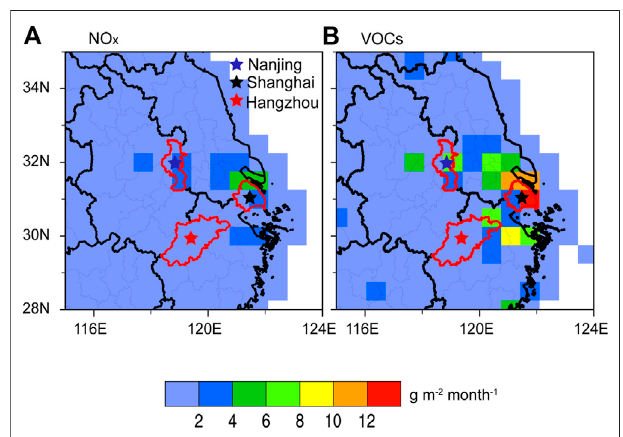
FIGURE 1 | Monthly anthropogenic (A) NO x emissions and (B) VOCs emissions(g m − 2 month − 1 )from the MEIC inventoryin theYangtze RiverDelta (YRD) region averaged for May – October 2017. Red enclosed areas indicate Nanjing, Shanghai, and Hangzhou,